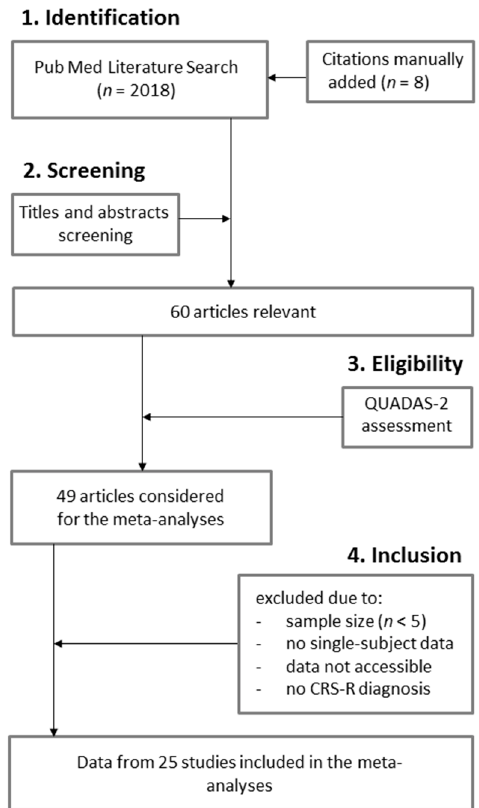
Figure 1. PRISMA Flow Diagram.